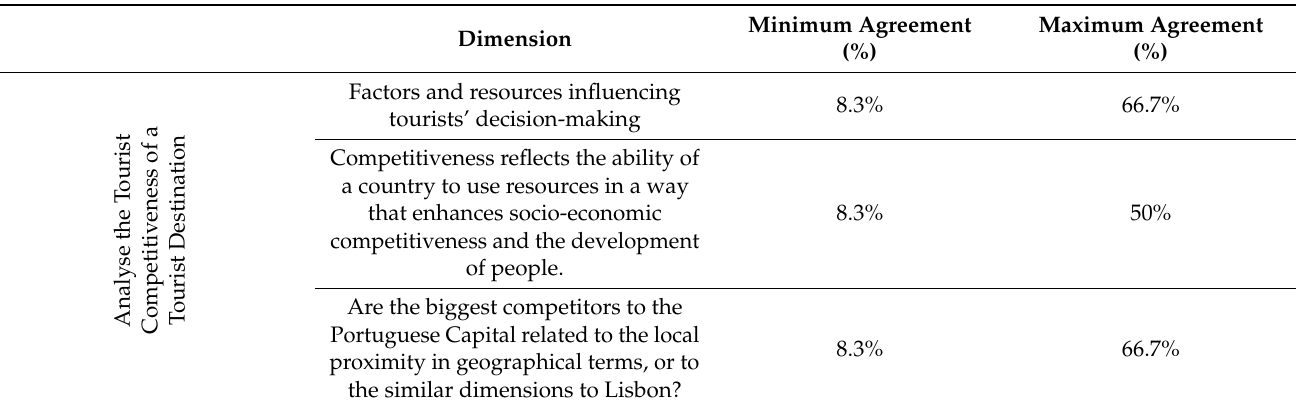
Table 6. Maximum and minimum agreement of the first domain of the interviews. Source: Elaborated by the author.